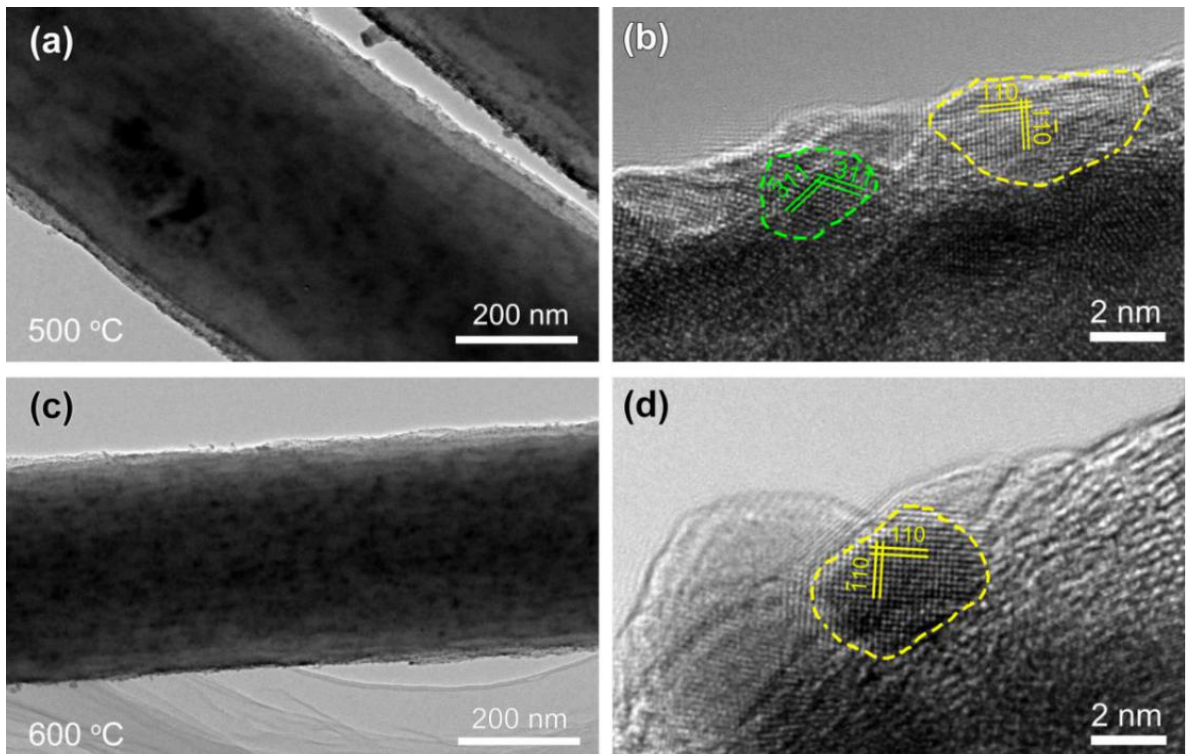
Figure 4. ( a , b ) and ( c , d ) are TEM and HRTEM images of CF-P 500 and CF-P 600 samples, respectively. In order to clarify the annealing reaction mechanism of cobalt acetylacetone and iron acetylacetone supported by heterogeneous submicron fibers, thermogravimetry (TG) curves of cobalt acetylacetone (blue line C) and iron acetylacetone (red line F) heated to 900 ◦ C